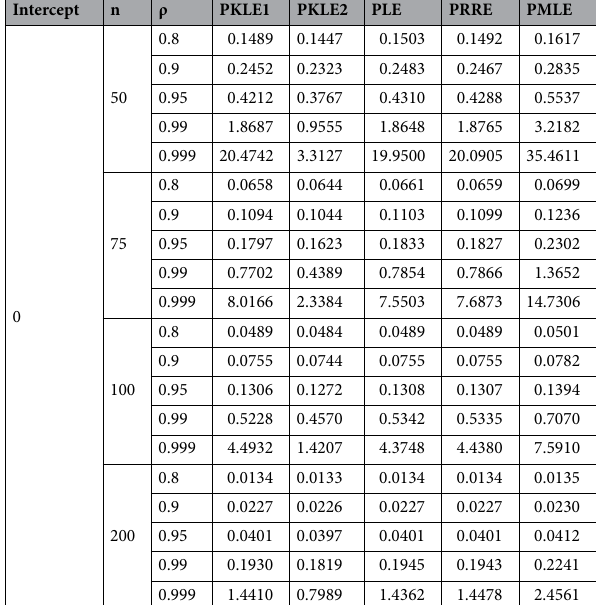
Table 5. Simulated MSE when p = 7 and intercept = 0.